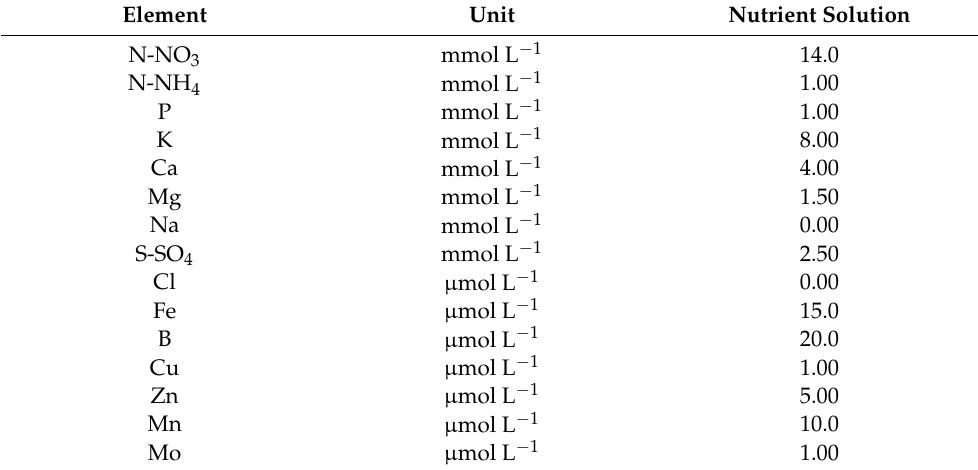
Table 1. Formulation of standard nutrient solution used for tomato cultivation.